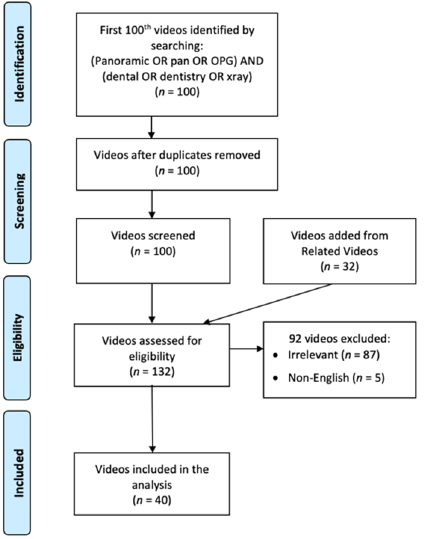
Figure 1. A flow chart showing the screening process of the YouTube videos. The number of views, comments, likes, and channel subscribers were recorded, as well Ethical approval was not applicable to this study. as the video duration and the age of the video. Pearson correlation tests were conducted to evaluate if any of these performance metrics were significantly correlated. A test was considered significant if p <